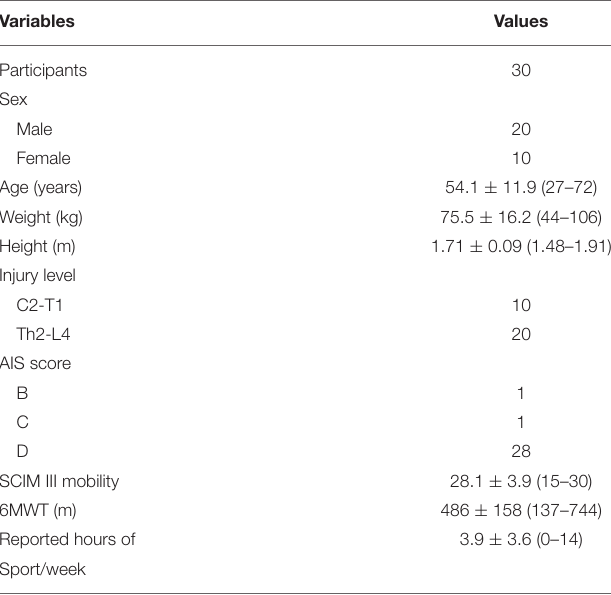
TABLE 1 | Demographics and assessment scores (SCIM III sub-section mobility and 6MWT) of all participants.